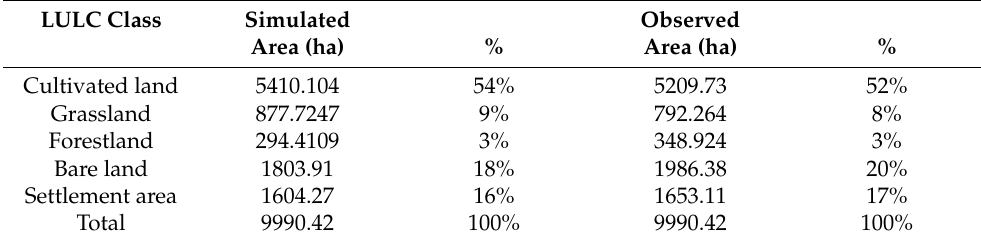
Table 12. Comparison of actual and projected LULC